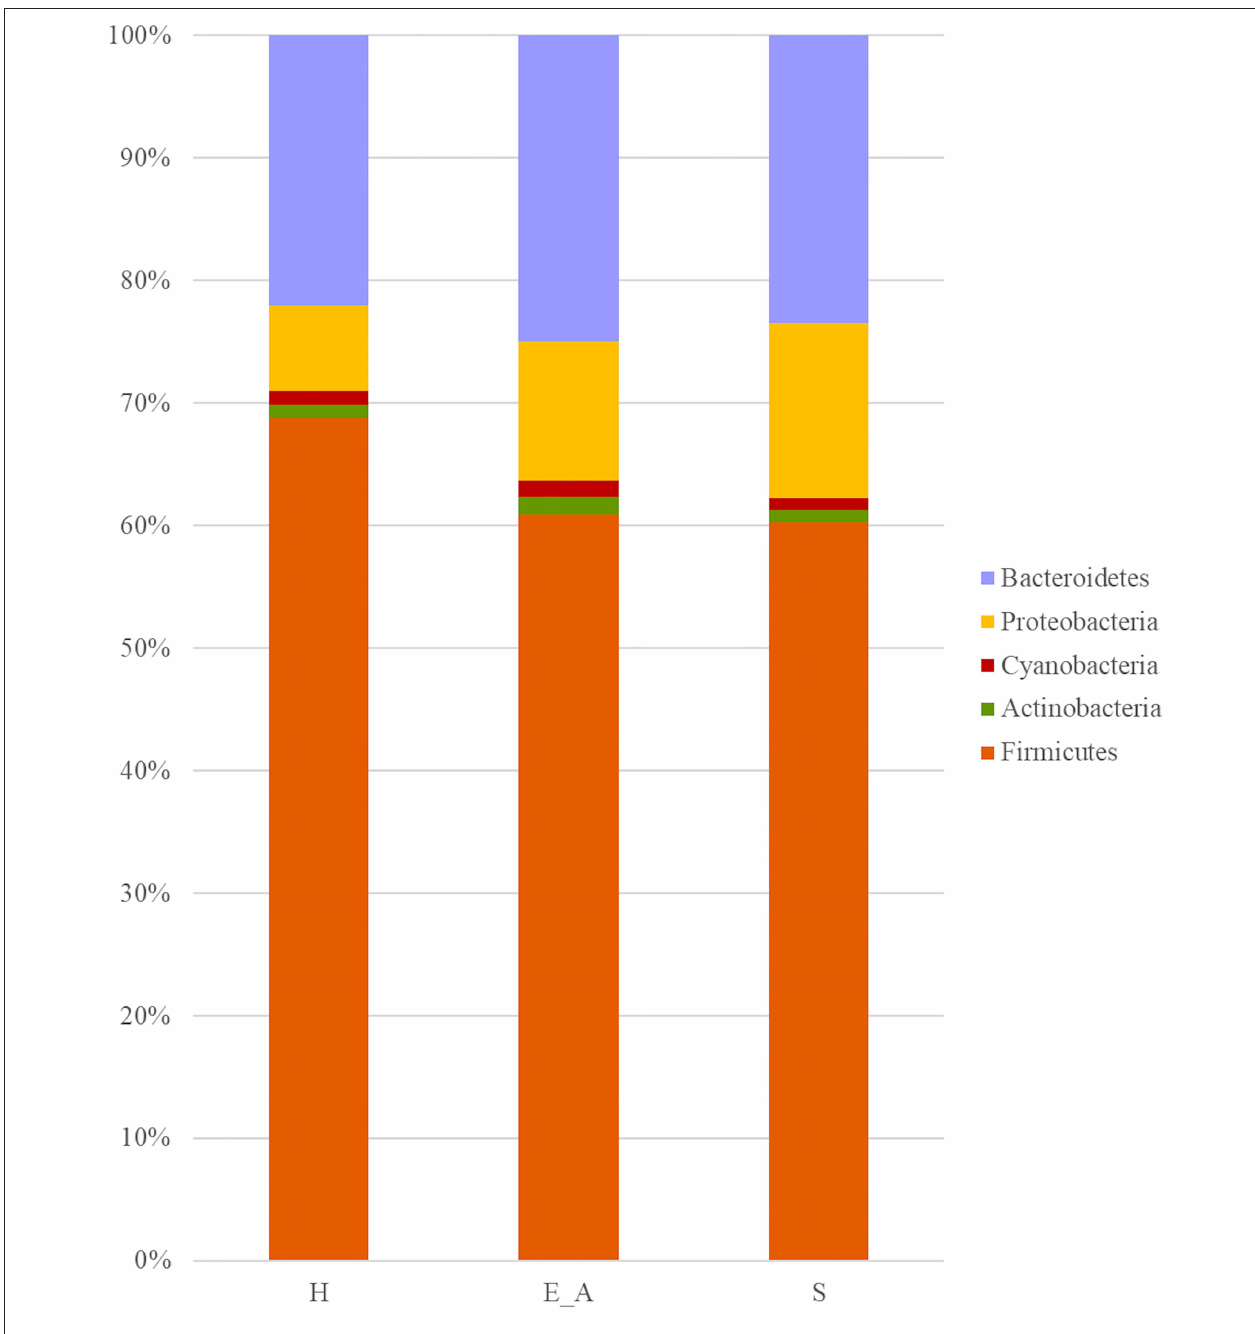
FIGURE 3 | Bar plot representation of phylum relative abundance in the three groups. Only phylum with a relative abundance above 0.5% were reported in the